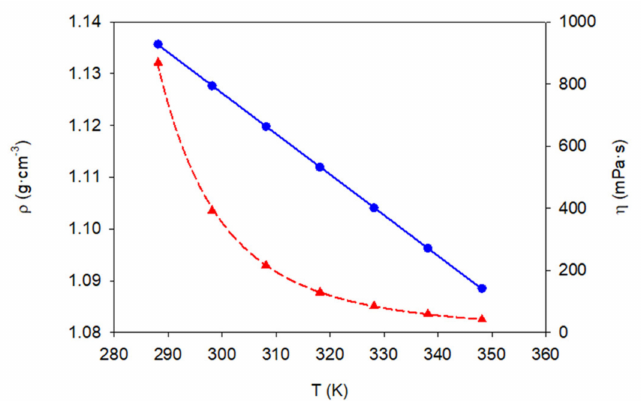
Figure 3. Physical properties of the eutectic mixture of AOT + PEG-600. Legend: • density, (cid:78) viscosity. The blue, solid line and the red, dashed line represent the correlations by means of Equations (10) and (11),